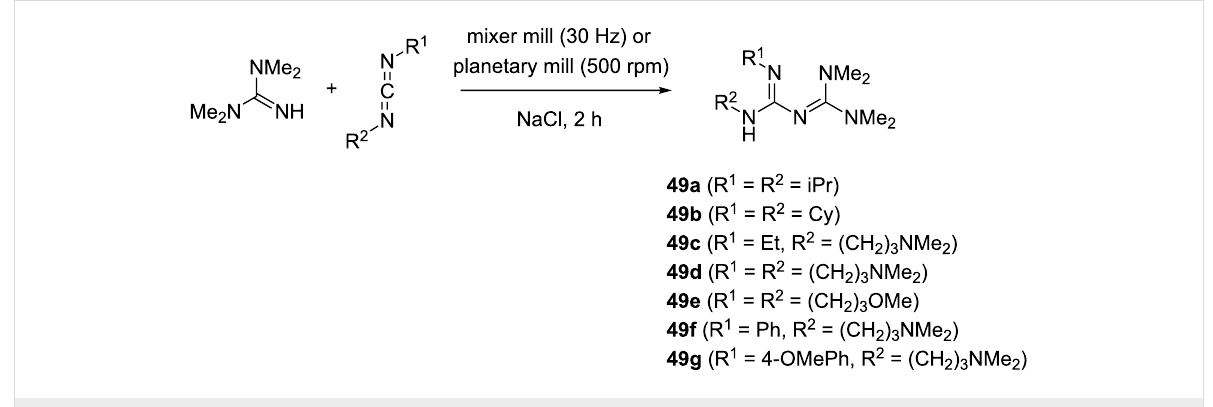
Scheme 22: Synthesis of highly basic biguanides by ball milling.